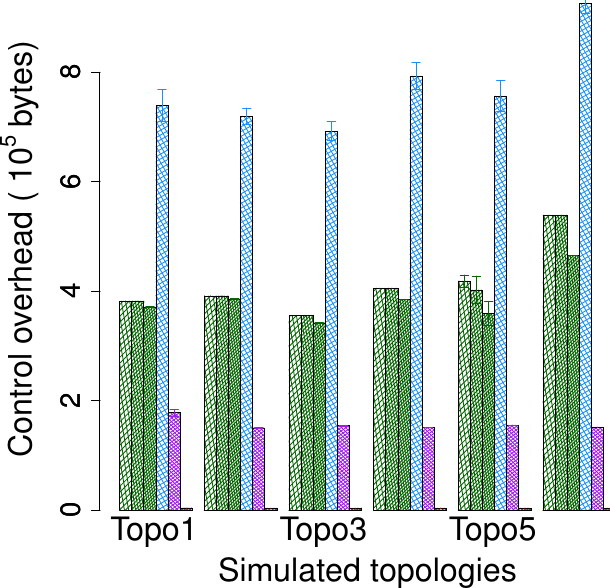
Figure 15. Total amount of control packets